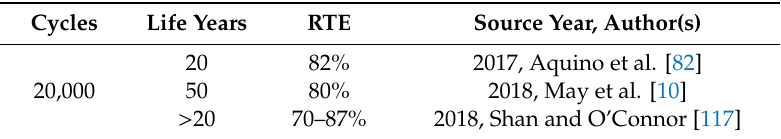
Table 25. Cycles, life years, and RTE of